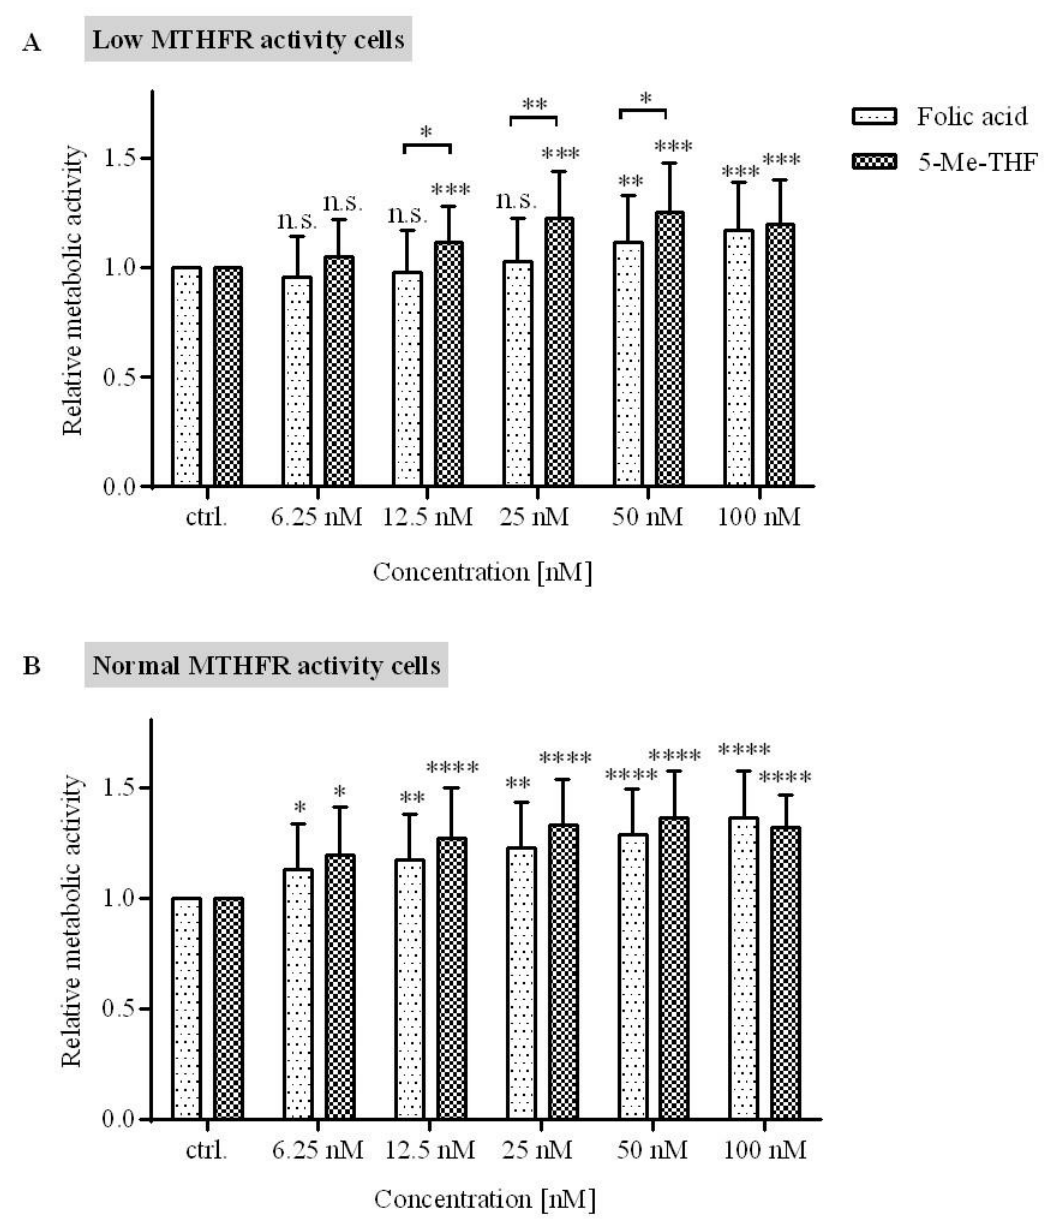
Figure 4. The influence of folate supplement type on the metabolic activity in LCLs with diverse MTHFR enzyme activity. ( A ) Cell lines with predicted low MTHFR activity ( n = 15). ( B ) Cell lines with predicted normal MTHFR activity ( n = 12). LCLs were maintained in folate-deprived media and then treated with five di ff erent concentrations of FA and 5-Me-THF for 72 h. Metabolic activity was assessed by an MTS assay. The response is expressed as fold change over vehicle-treated control. Values are means ± SD. Statistical di ff erences were determined by two-way ANOVA with a post hoc Dunnett’s multiple comparisons test. n.s. (not significant) p > 0.05, * p ≤ 0.05, ** p ≤ 0.01, *** p < 0.0001, **** p ≤ 0.0001, compared to control.